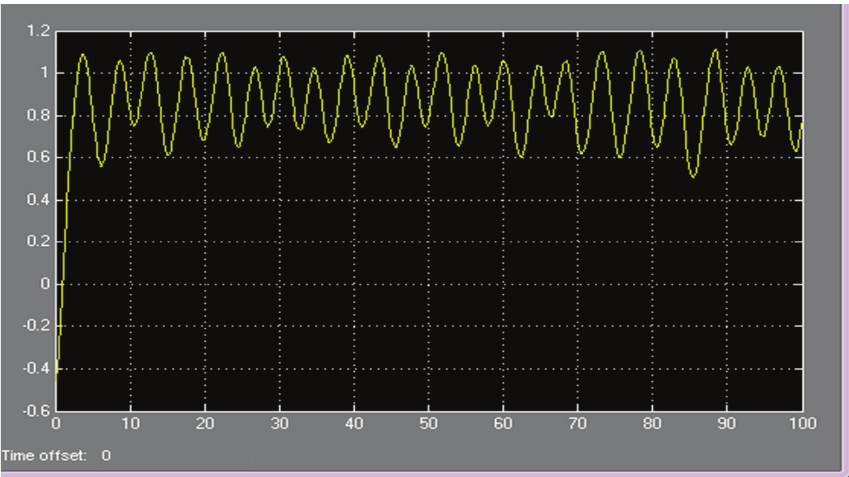
Figure 8: Response of the optimized LZ controller to a unit disturbance; the magnitude of controller response is shown over 100sec interval.